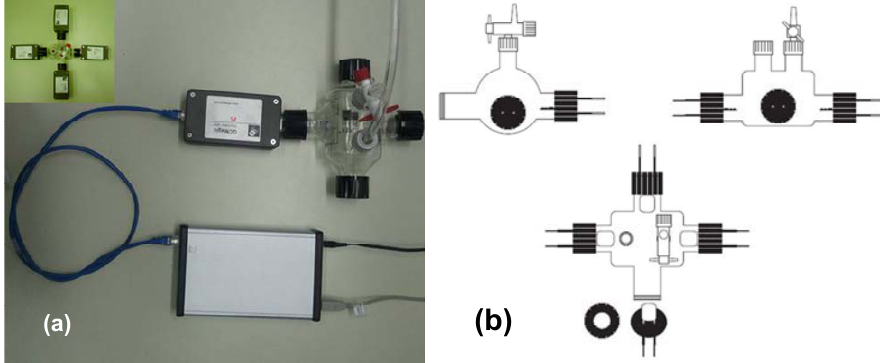
Figure 1. Experimental set up used for the determination of CO configuration and multi quartz configuration (inset of Figure 1(a)); ( b ) Schematic of the atmosphere-controlled